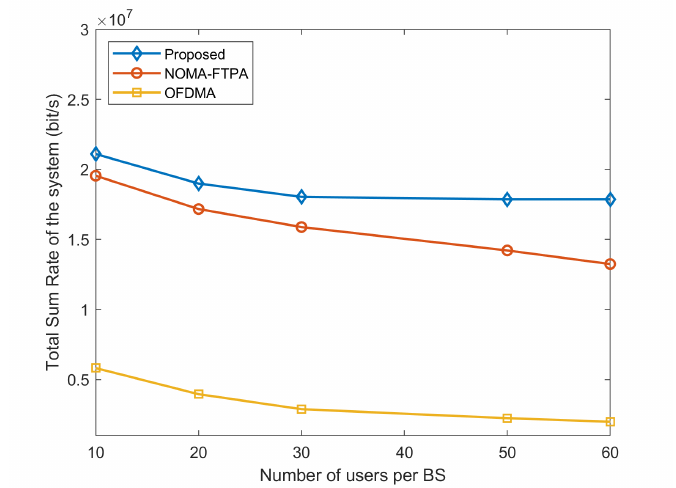
Figure 4. Total sum rate of the system versus different number of users per